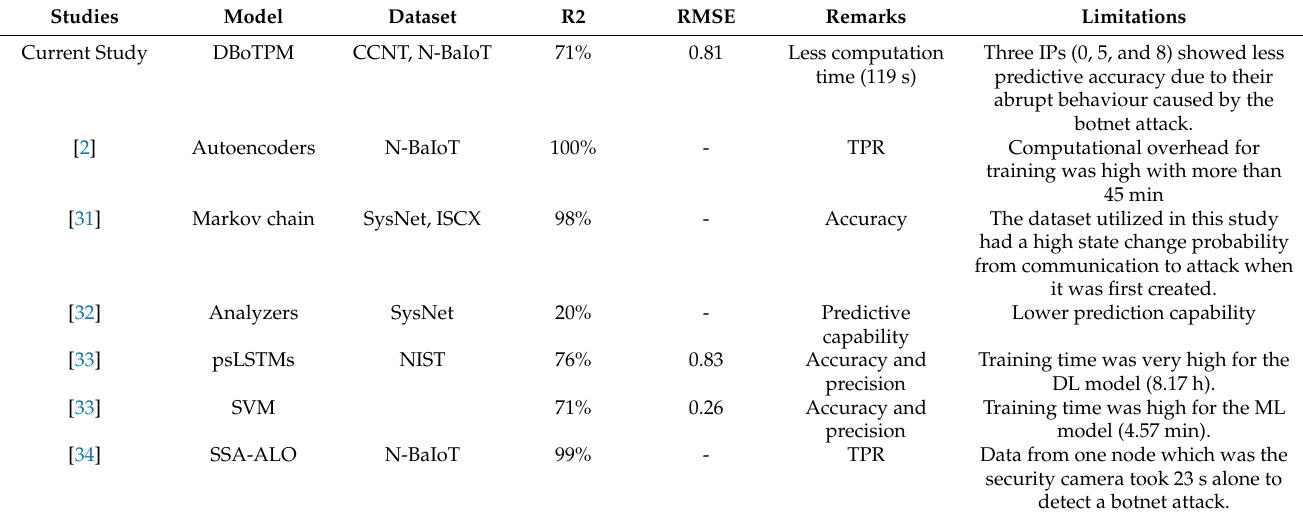
Table 4. Comparison of the DBoTPM model for botnet prediction used in the present investigation with other studies.